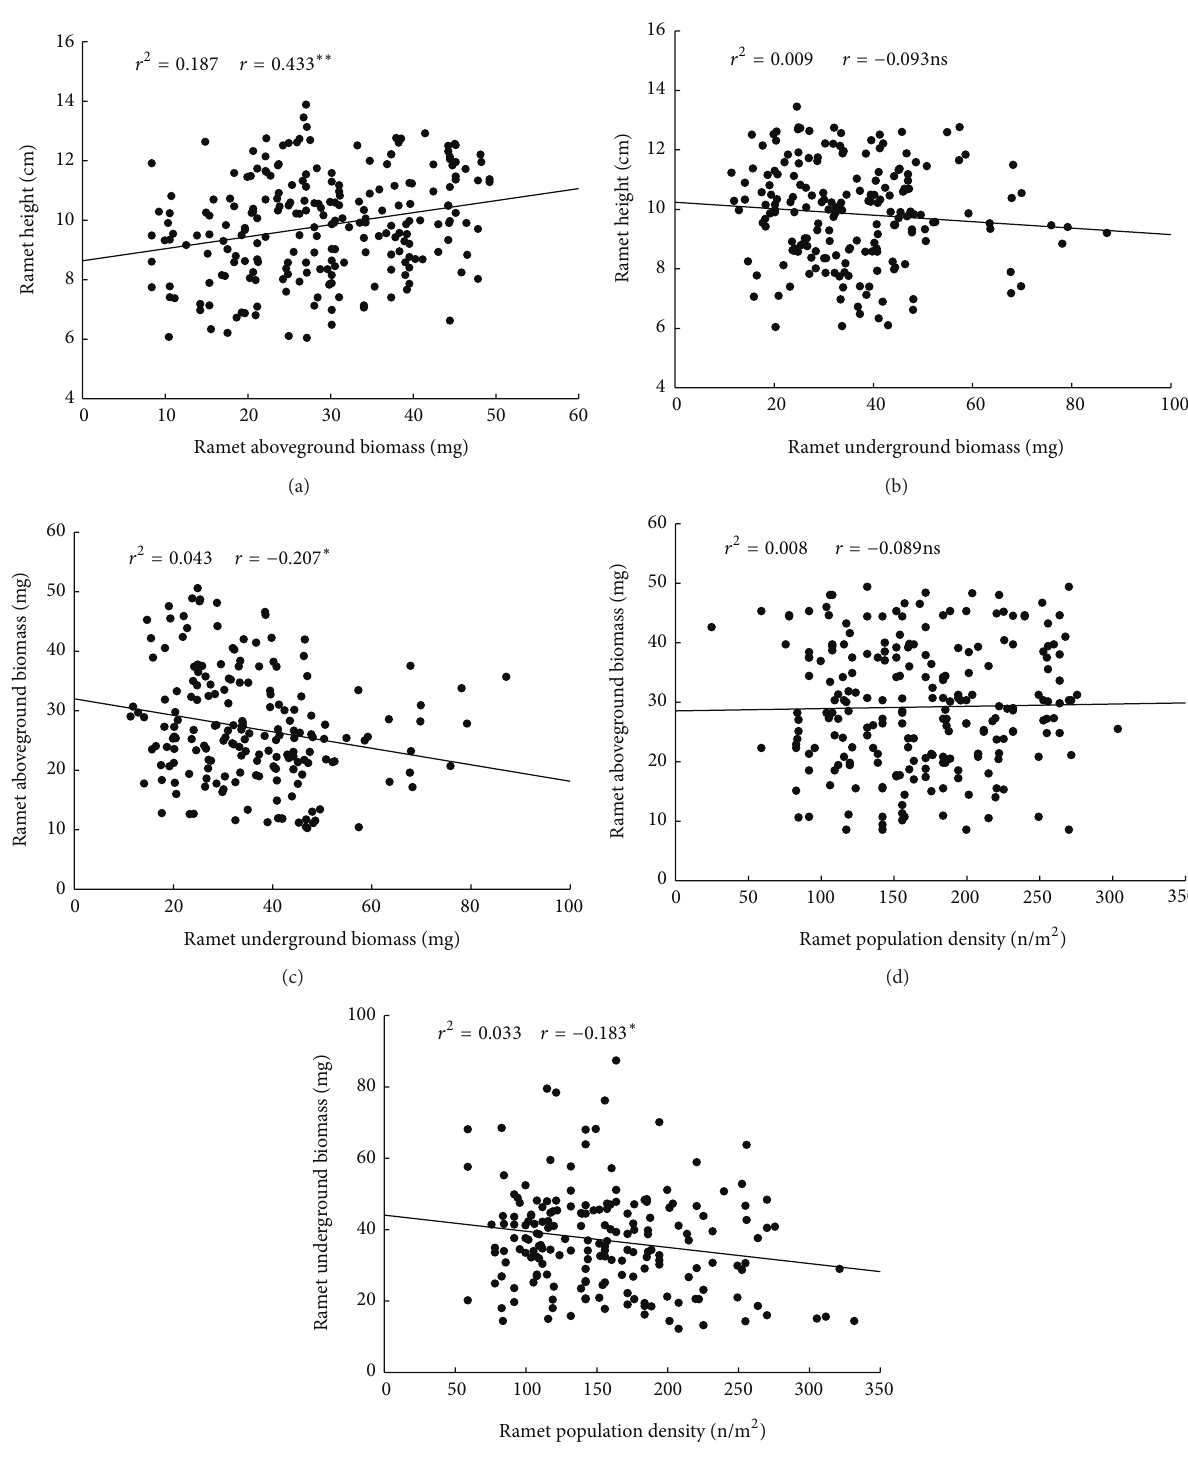
Figure 6: The linear regression between different quantitative characteristics of Carex physodes ( ∗∗ 𝑃 < 0.01 , ∗ 𝑃 < 0.05 , and ns = no significant). Each point represents a separate ramet on different locations, 𝑛 = 21